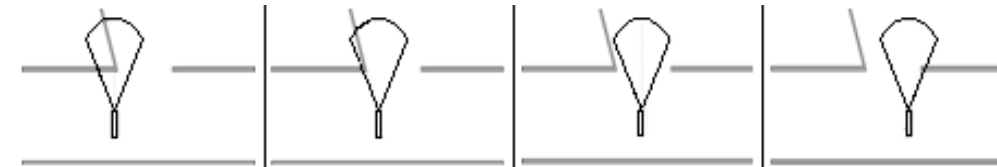
Figure 4. As a sensor moves along a corridor next to an open door, it detects the frame until no part of it is inside the area covered by the